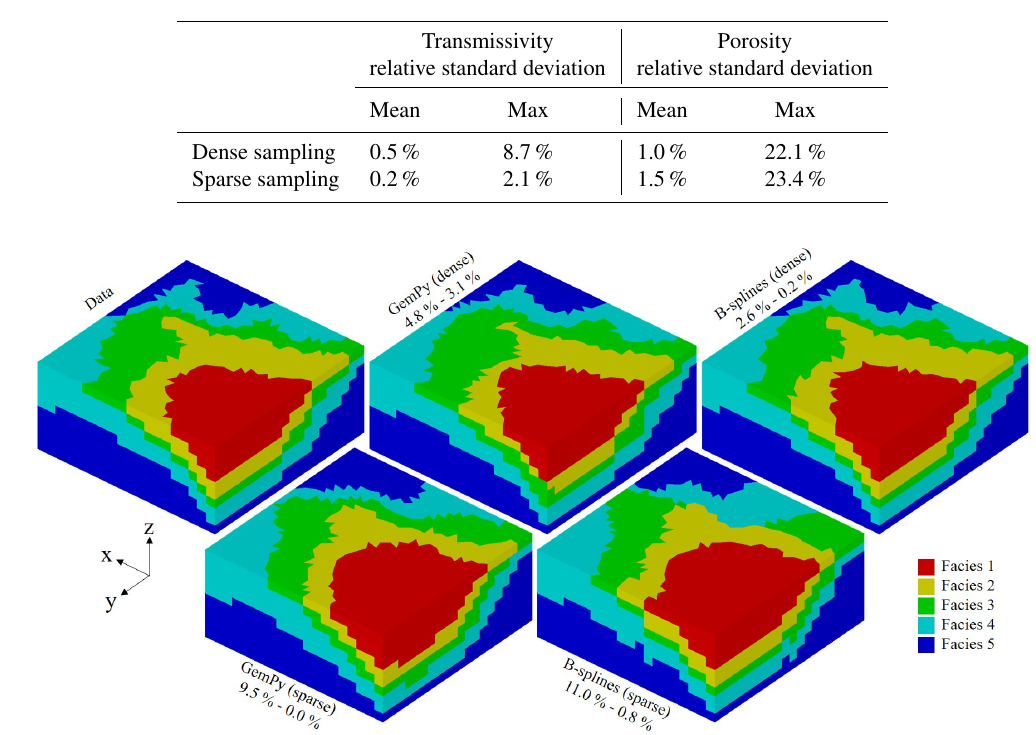
Figure 5. Facies distribution of the models – the different facies are in greyscale; each model is shown with the ratio of misplaced facies at the scale of the entire domain on the one hand and of the conditional data on the other